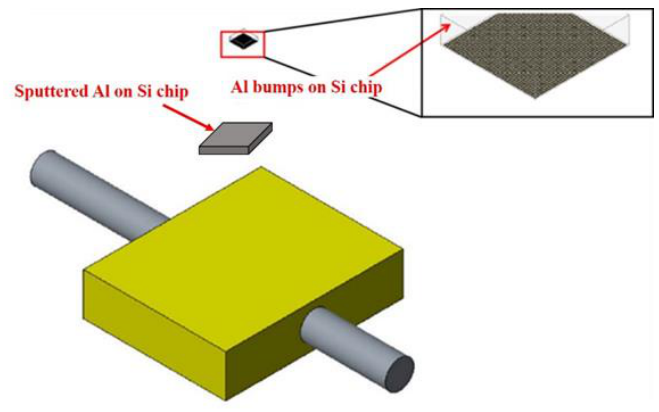
Figure 1. Simulation setup for ultrasonic bonding in this study.